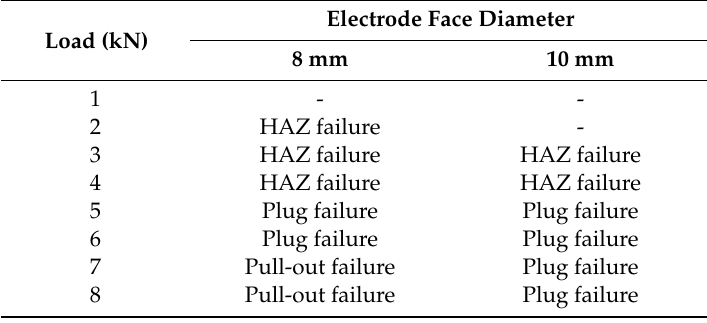
( b ) ( c ) Figure 8. Failure shapes with various failure modes at electrode face diameter of 8 mm: ( a ) pull-out failure, ( b ) plug failure, and ( c ) HAZ failure.